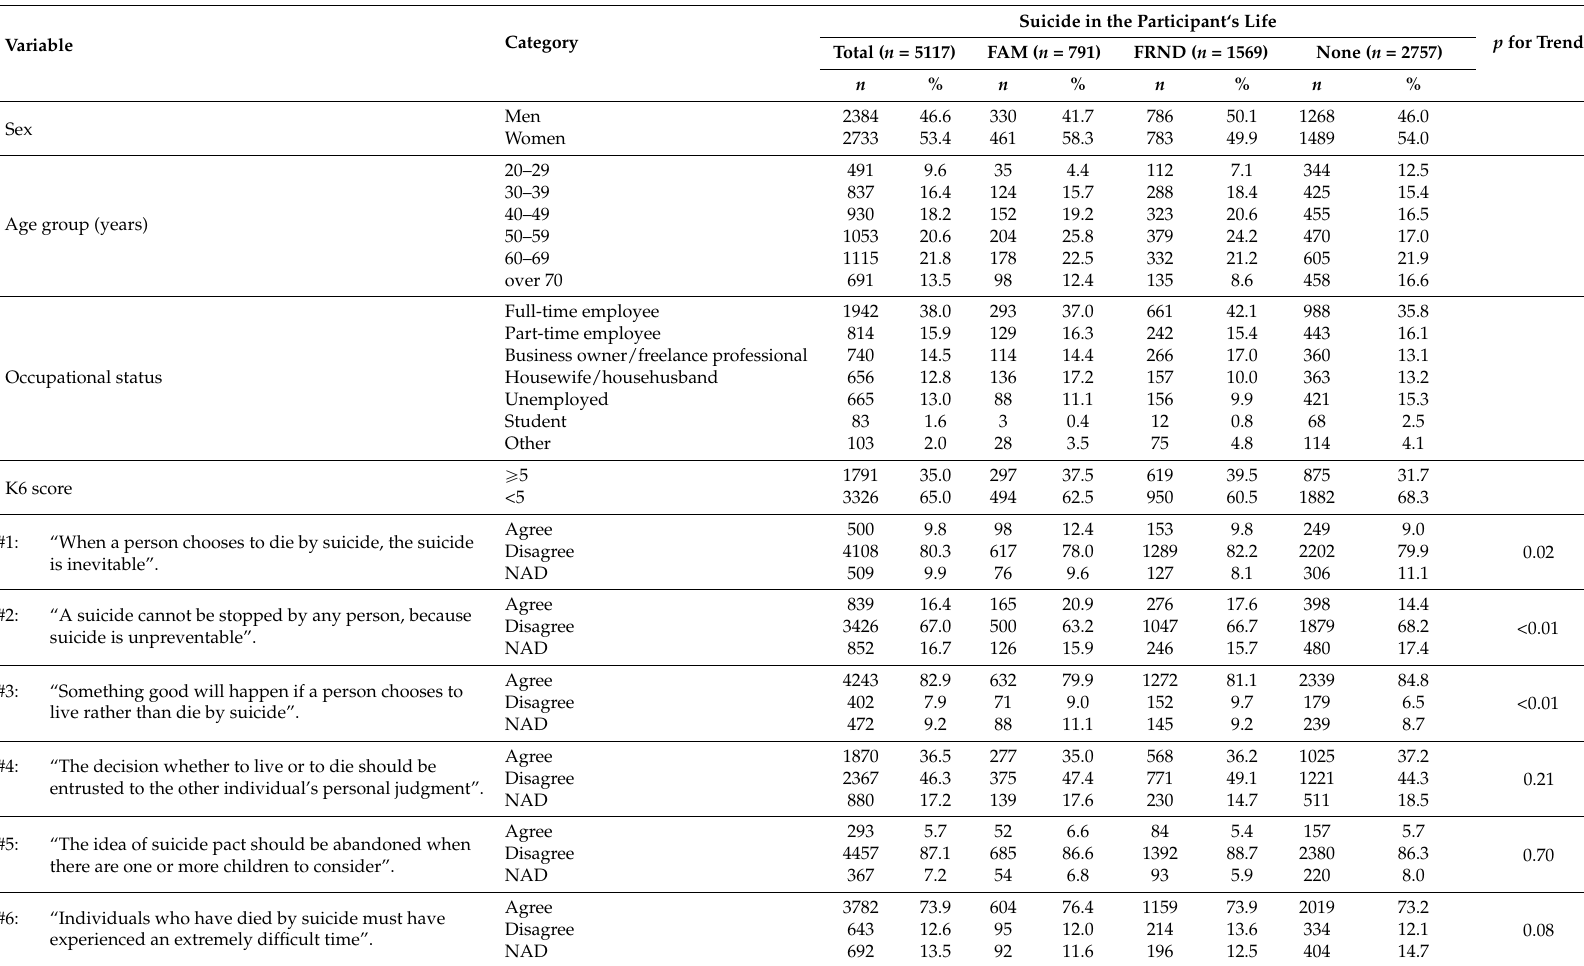
Table 1. Attitudes toward suicide, depressive symptoms as assessed by the K6 scale, and sociodemographic characteristics of 5117 participants who did or did know someone who had died by suicide.